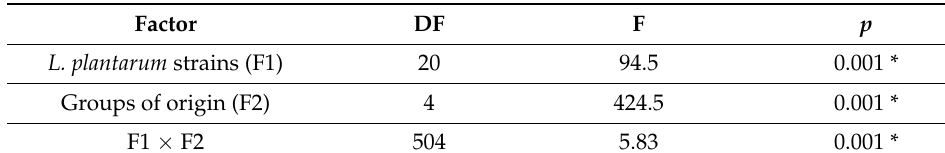
Table 8. The factors influencing in the average size of yeast colonies (mm) on RSM medium with L. plantarum strains, including the control variant, for each yeast strain. Factorial ANOVA, Statistica